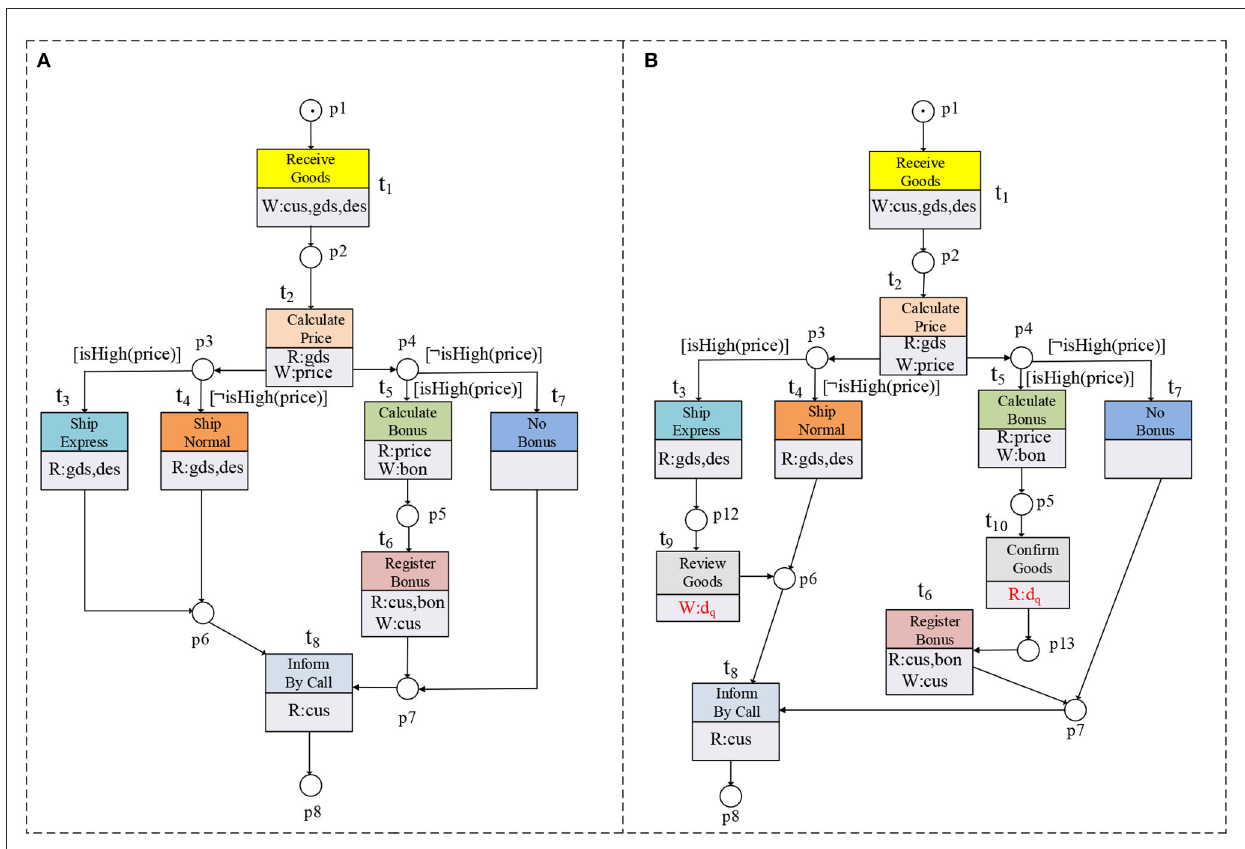
FIGURE1 Two shipper process models are shown in (A, B) . There are no correspondences of t 9 , t 10 , and d q in (B) .